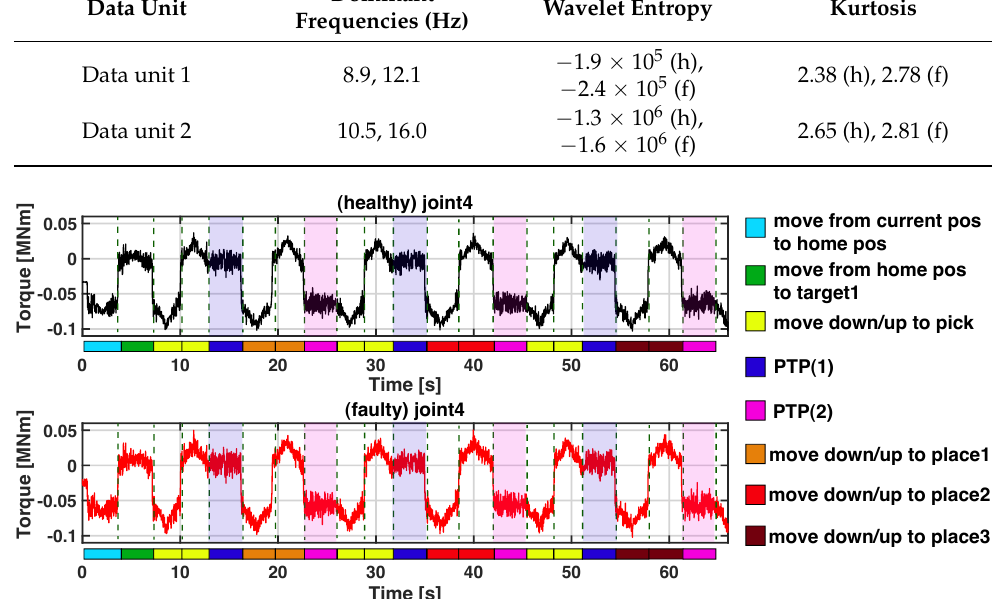
Figure 12. Fourth joint torque acquisition in the case of healthy (in black, above) and faulty (in red,